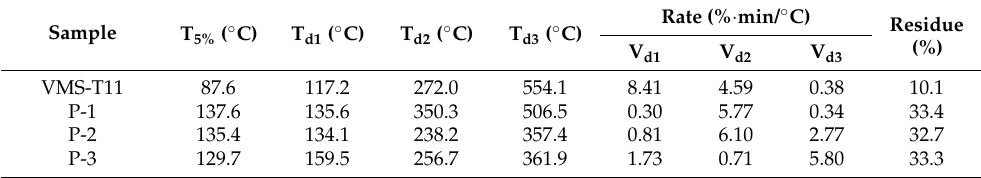
Table 1. Thermal degradation characteristics (the prepared materials and their